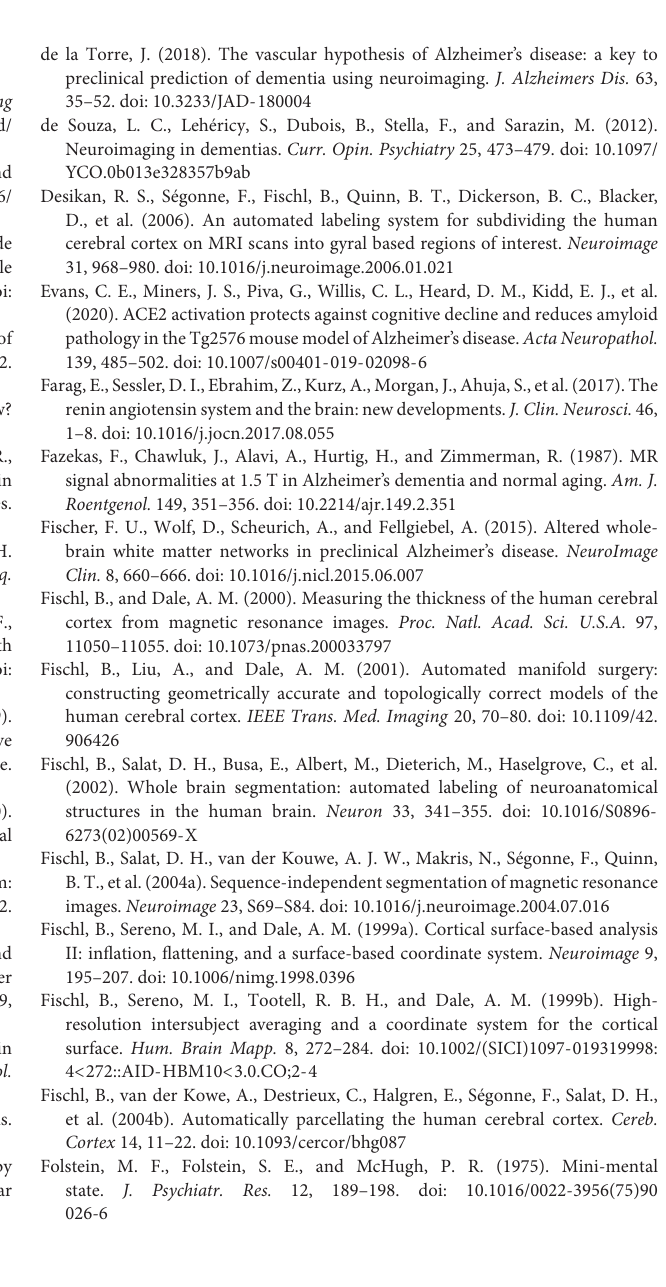
Supplementary Figure 1 | Validation of T1-weighted White Matter Hypointensities volume against Fazekas scale in the whole sample. White matter hypointensities volume correlated with Fazekas scale (A) and was different across groups defined by Fazekas score (B) - p = 0 . 005